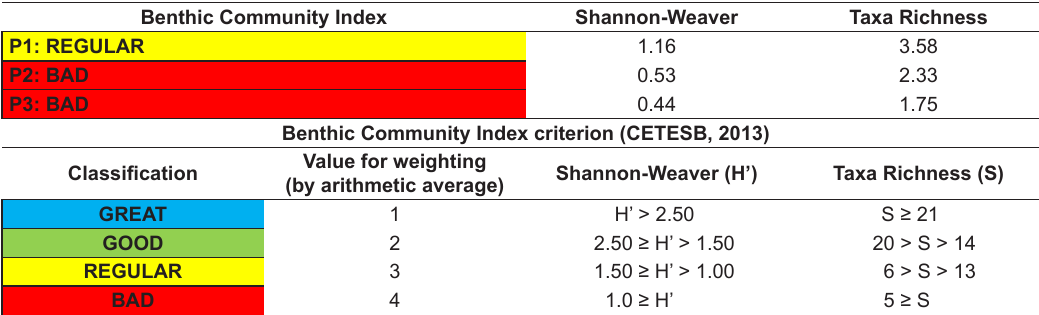
Table 5. Results of the benthic community index (BCI) based on the diversity and richness (average among samples by site).